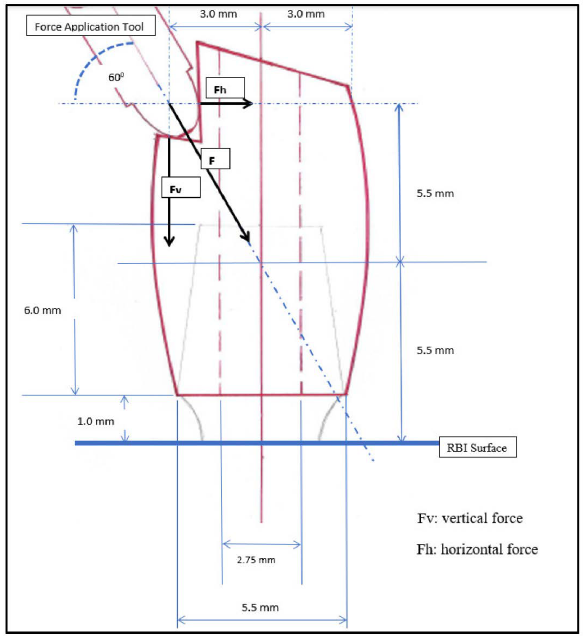
Figure 2. Prosthetic tooth design (bucco-lingual section): the point of force application, F, is on the lingual aspect.